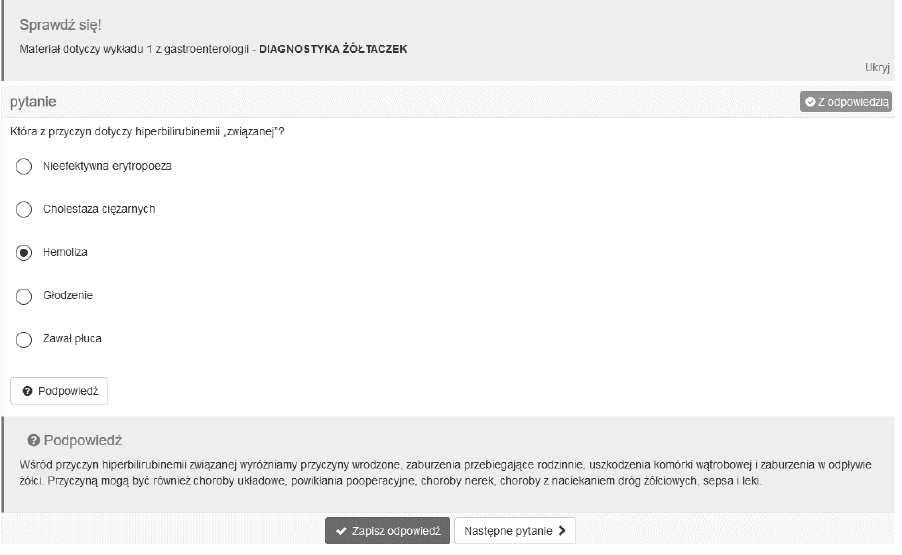
Figure 6. Self-test question as a follow-up to an e-learning lecture in Gastro- enterology for year 5 students of Medicine, with an example teacher’s